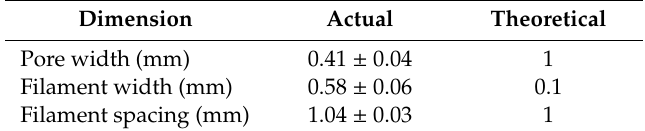
Table 2. Dimension of printed structures from composite B.